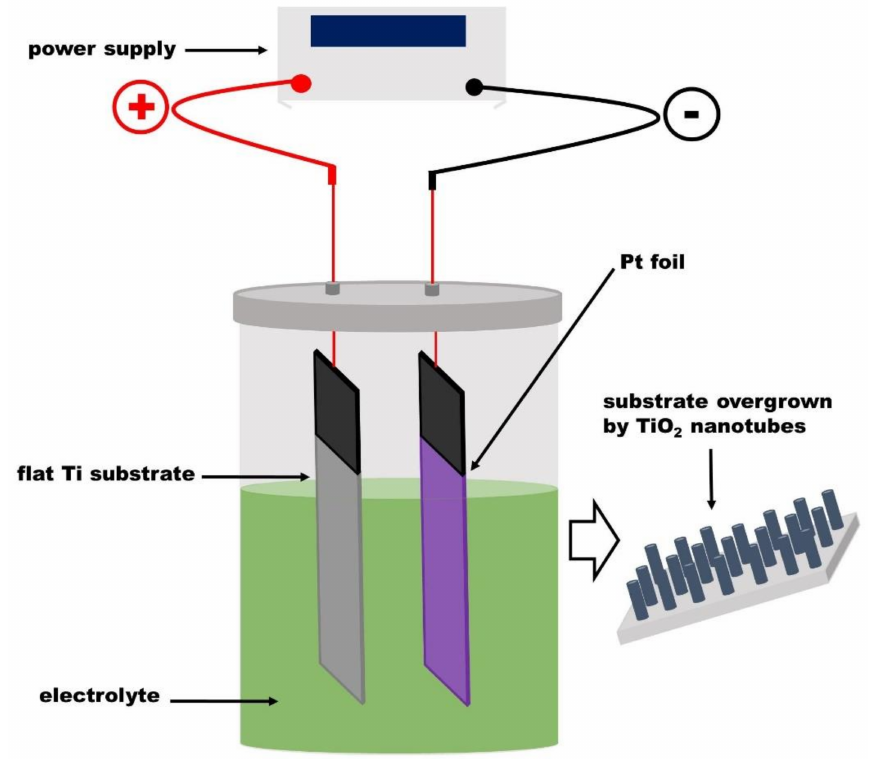
Figure 5. Electrochemical anodization